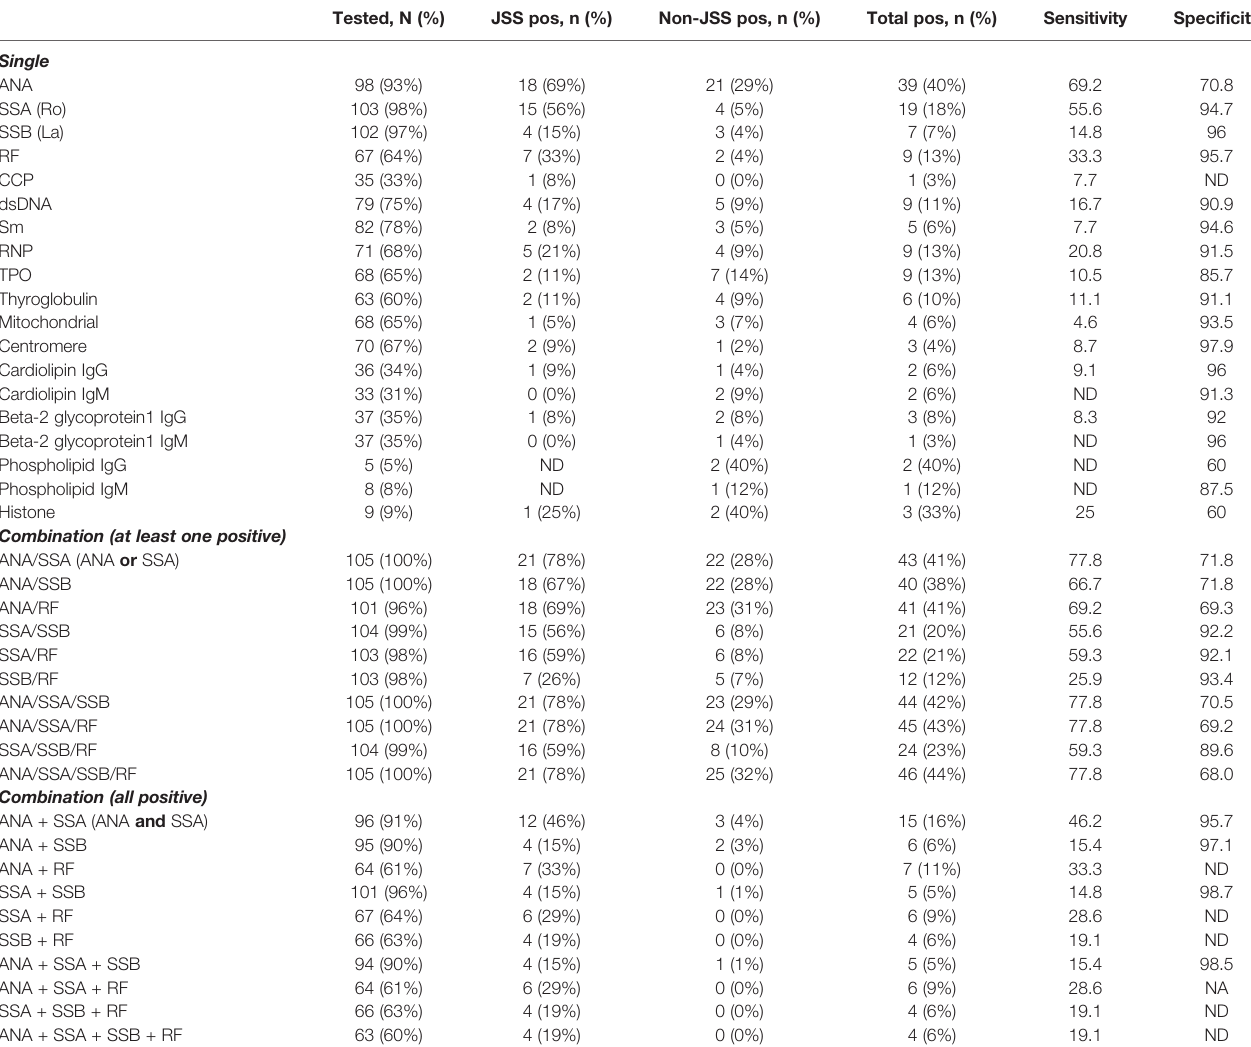
TABLE 2 | Diagnostic performance of cSjA for JSS